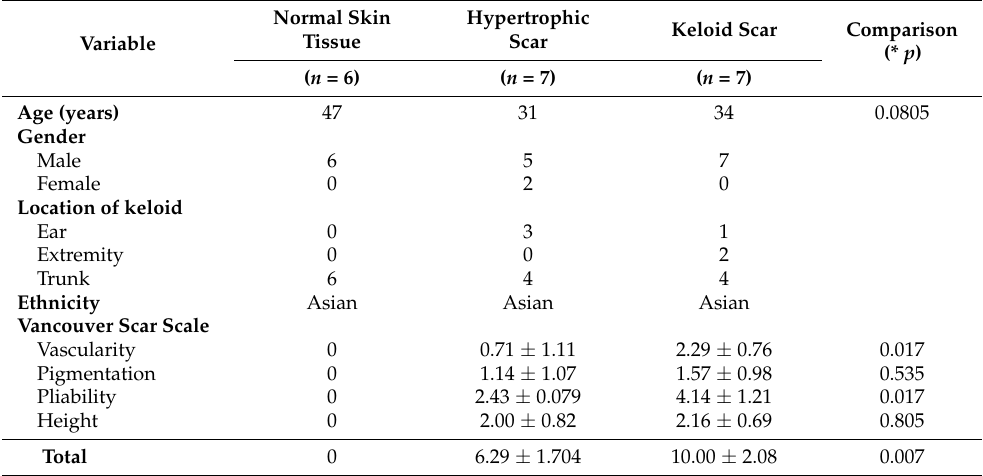
Table 1. Categorization of Normal, Hypertrophic and Keloid (NHK) scar tissues.